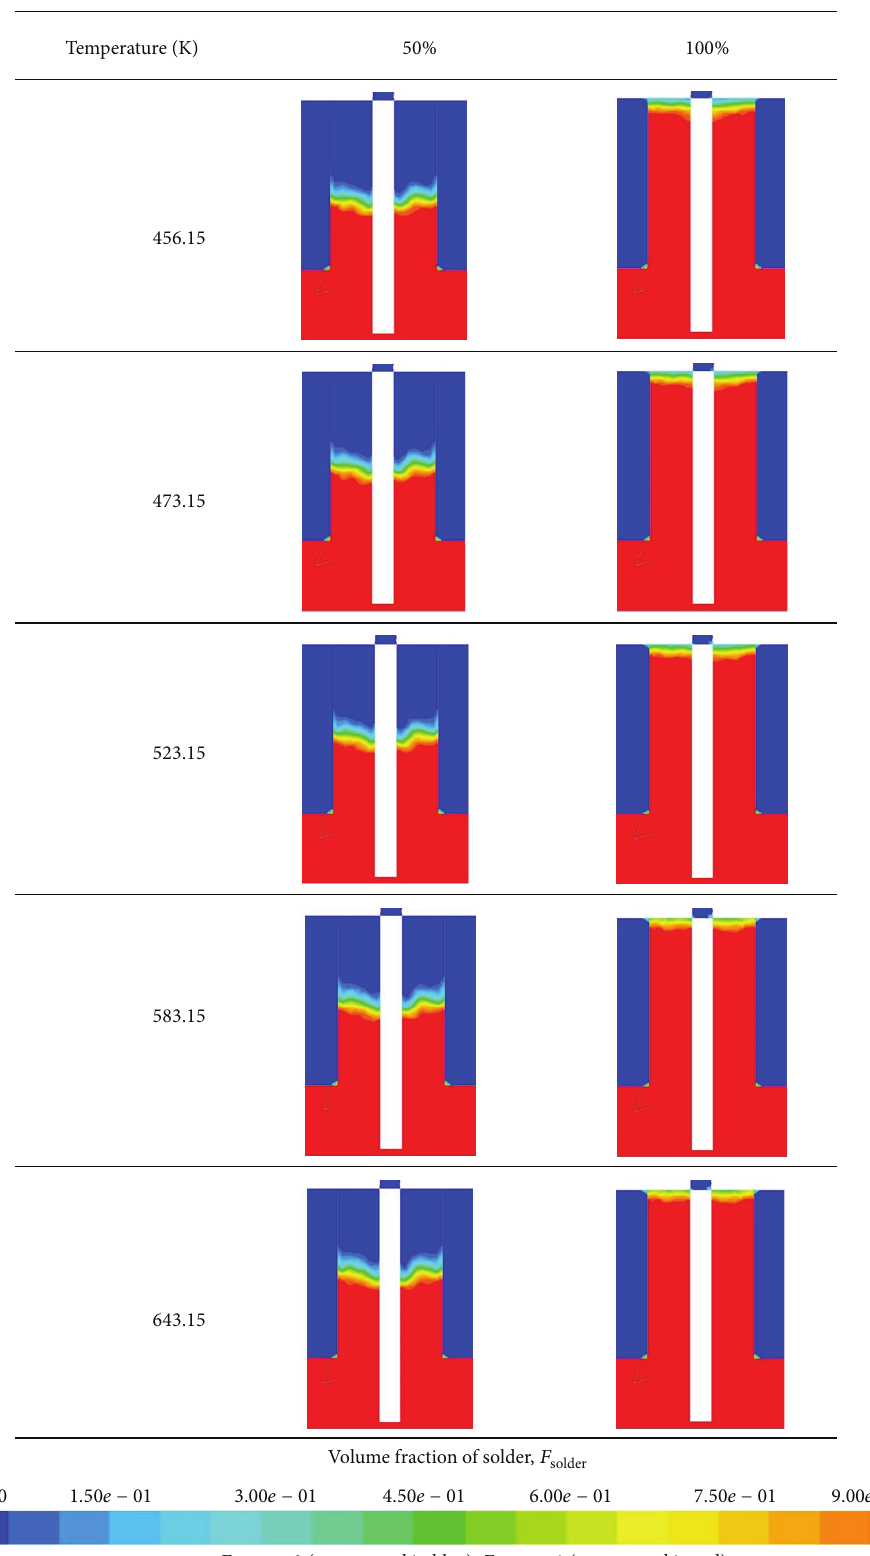
Figure 11: Filling profiles at 50% and 100% filling